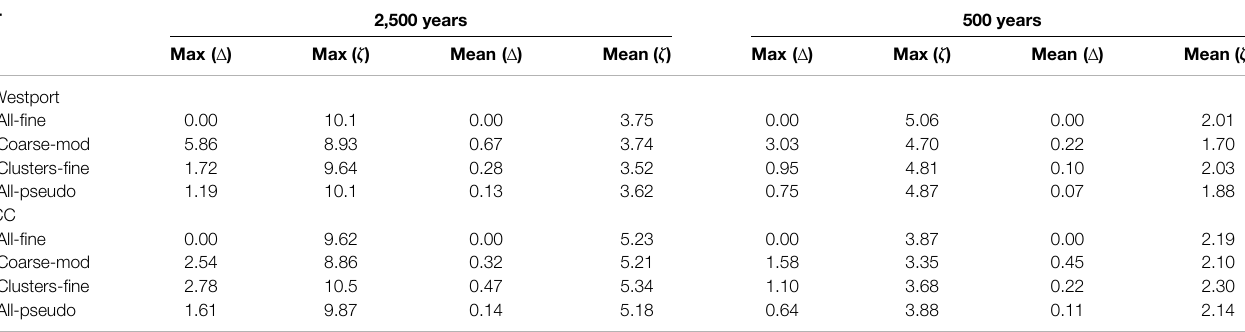
(cid:26)(cid:26)(cid:26)(cid:26)(cid:26) (cid:26)(cid:26)(cid:26)(cid:26)(cid:26) ζ cm − ζ f .For max max